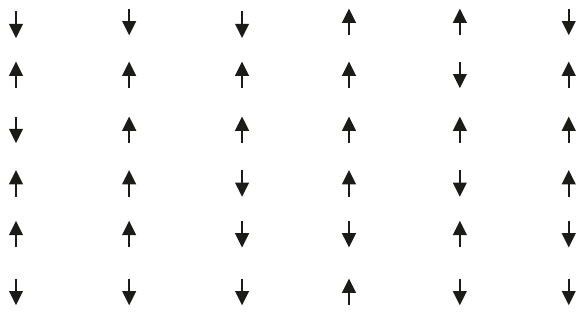
Figure 1: Ferromagnetic Ising